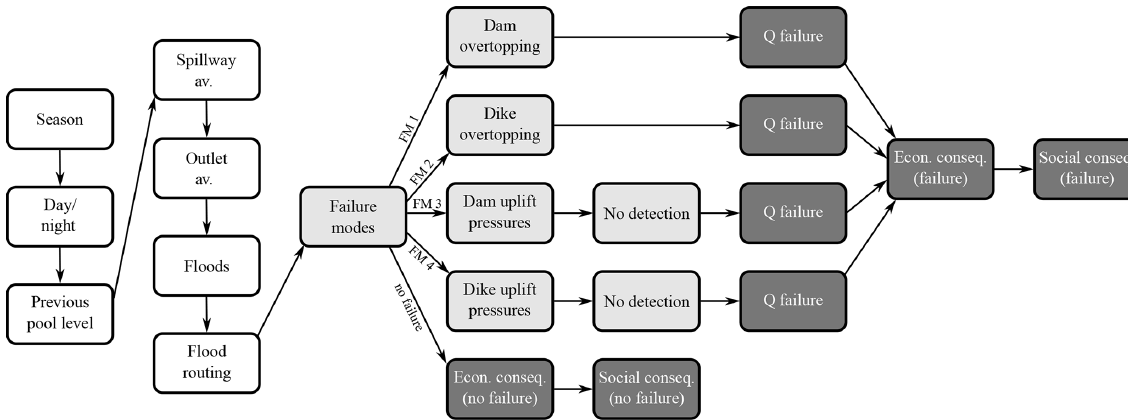
Figure 3. Diagram of the quantitative risk model for the Santa Teresa dam.